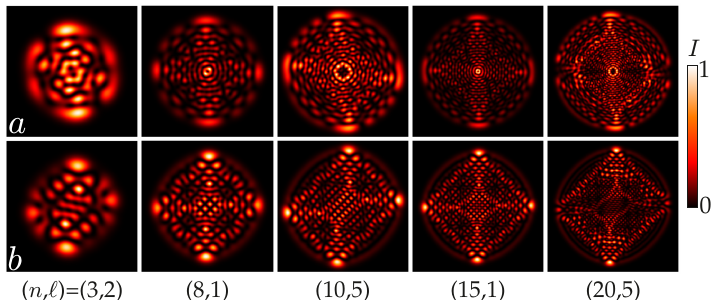
Figure 1. Computer simulation of the astigmatic transform of sLG beams ( a ) into asLG beams ( b ) with (cid:101) = 1, θ = π /4, and β = π /3 for some quantum number pairs ( n , (cid:96) )